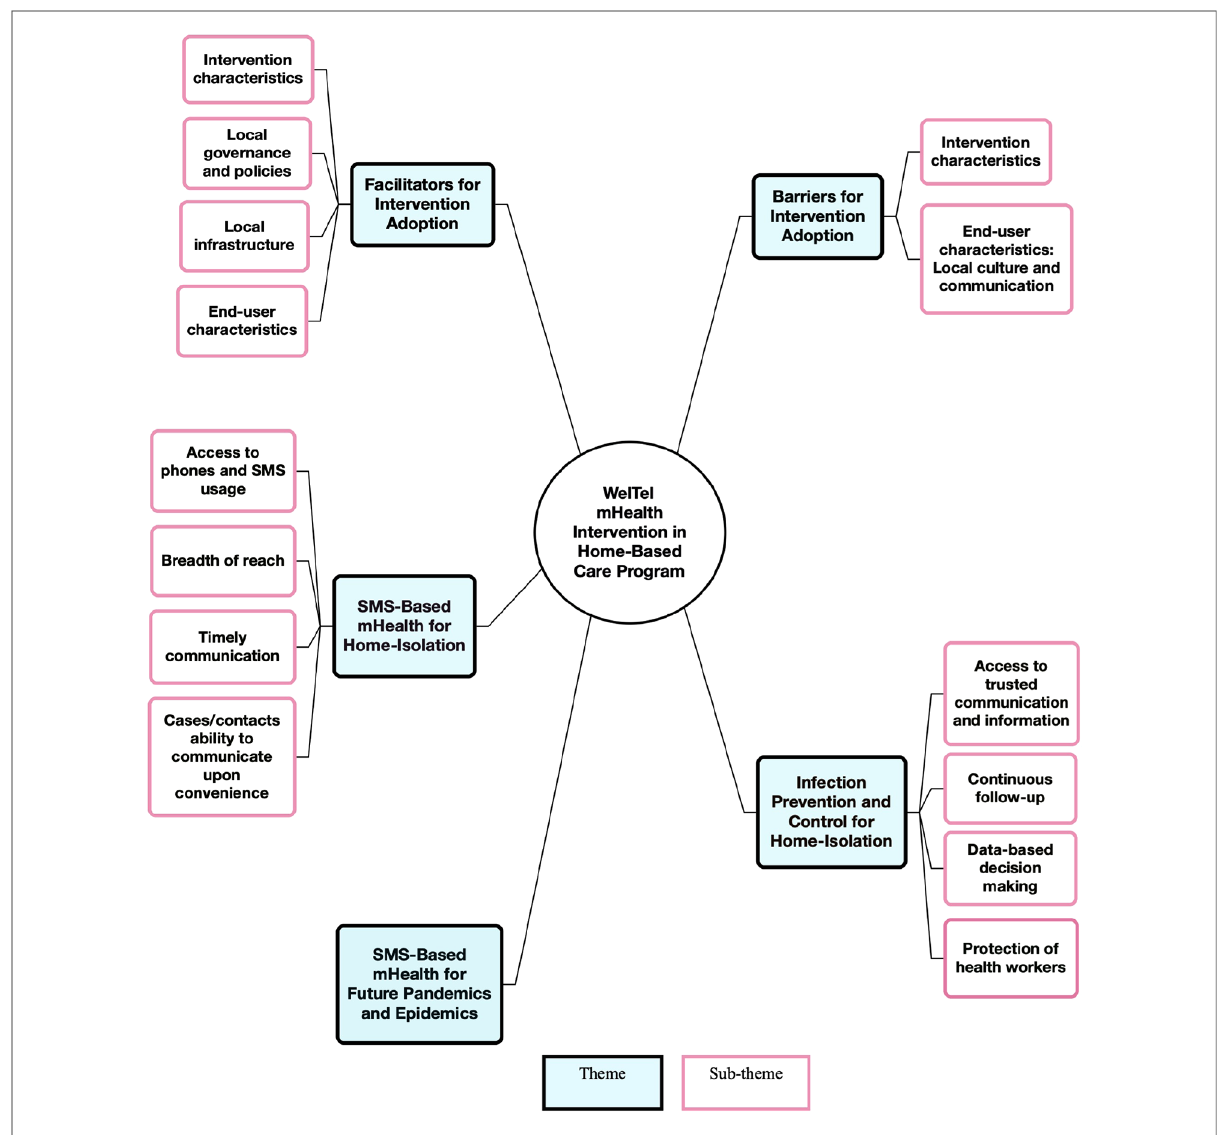
FIGURE 3 Thematic map: key themes and